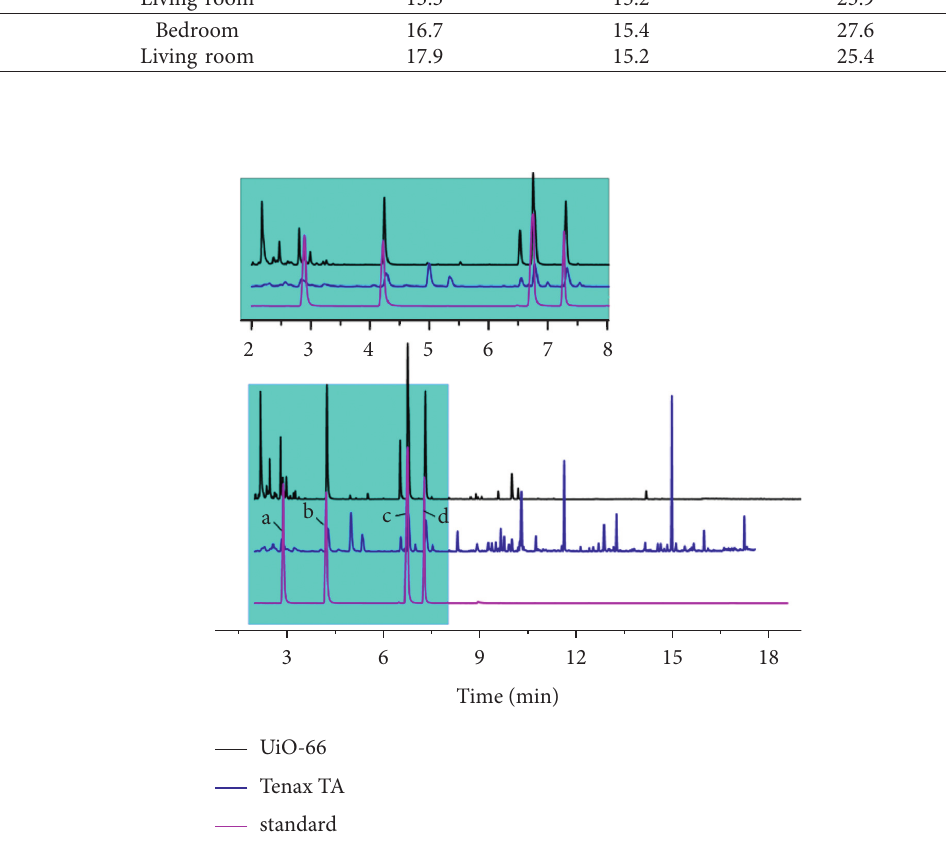
Figure 5: Chromatograms of samples of standard, enrichment on Tenax TA and UiO-66: (a) benzene; (b) toluene; (c) p, m-xylene; (d) o- xylene.